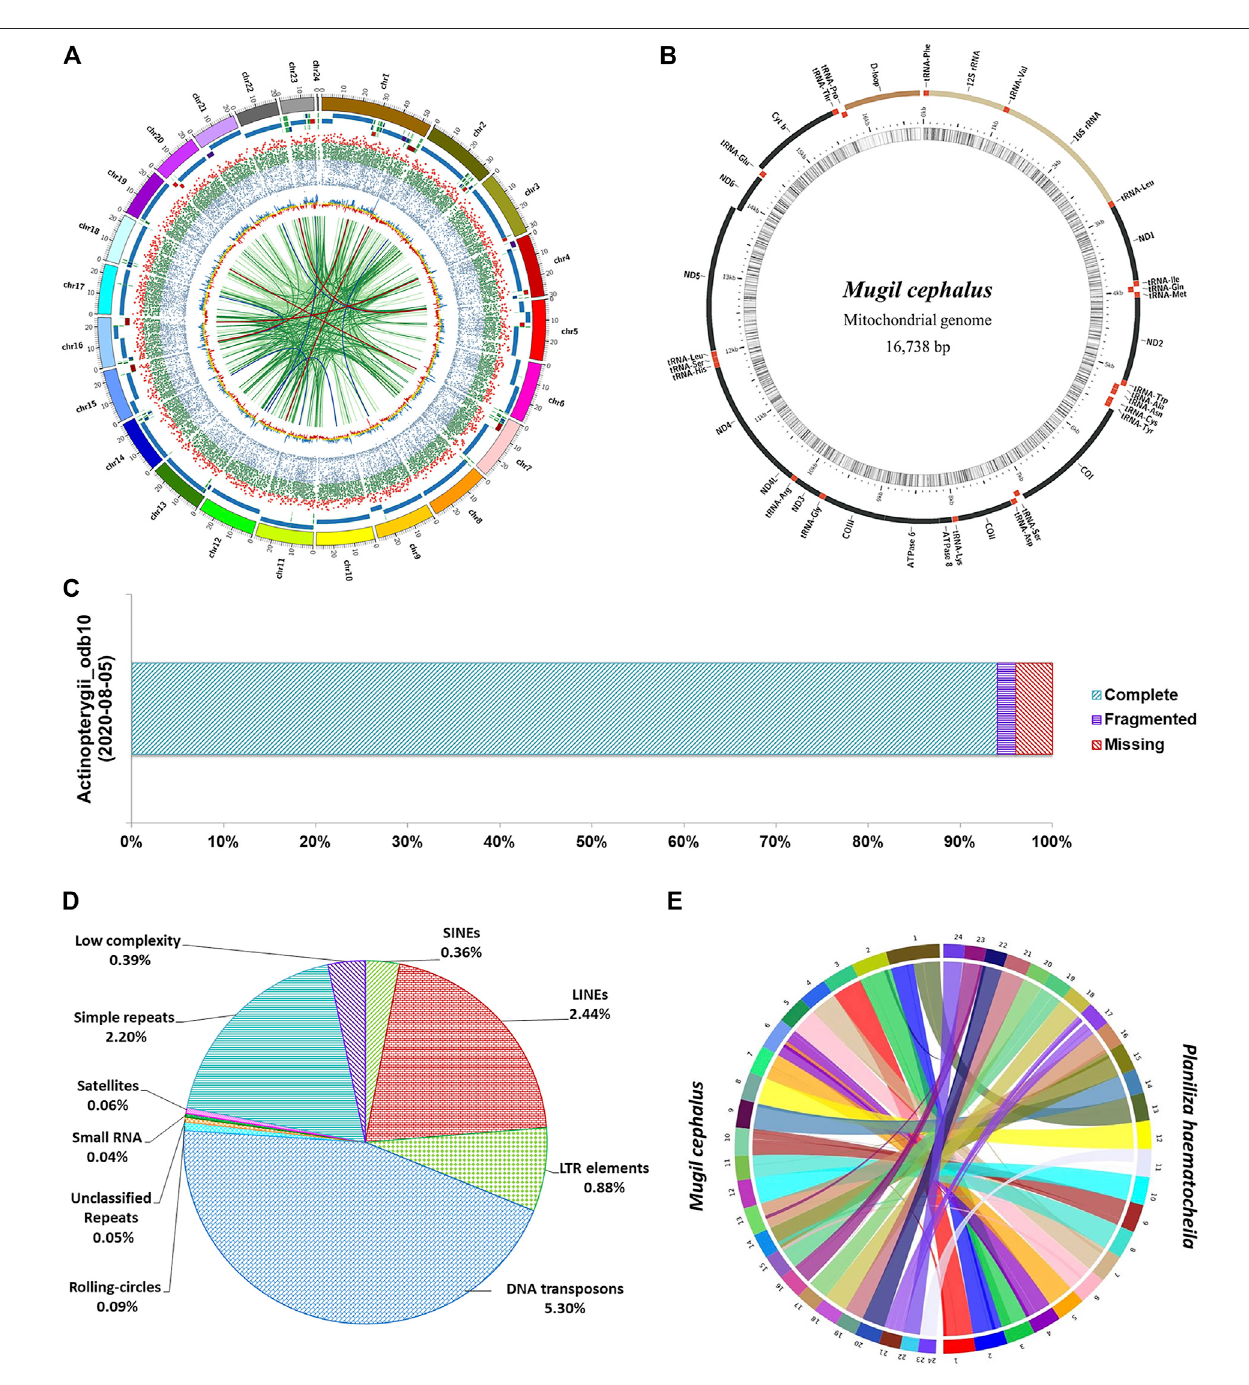
FIGURE 1 | Assembly of the M. cephalus genome. (A) Circos plot depicting the 24 pseudo-chromosomes in the M. cephalus assembly and their features. The track 1 (outermost) depicts 24 pseudo-chromosomes; track 2 depicts contigs represented as tiles (contigs < 5 Mb are shown in variable colors); track 3 shows protein- coding genes as a scatter plot (gene length of < 5 kb in blue, 5 – 30 kb in green > 30 kb in red); track 4 shows GC content of the genome as a yellow line plot (GC values > 43 in blue and < 41 in red); track 5 (innermost) depicts self synteny in the genome shown as a link plot (alignment lengths over 1,500 bp in light green, 2 – 3 kb in dark green, 3 – 3.5 kb in dark blue and > 3.5 kb in dark red). (B) Map of the complete mitochondrial DNA genome of M. cephalus . (C) BUSCO scores illustrating the completeness of the M. cephalus genome assembly. (D) Pro fi le of repetitive elements in the M. cephalus genome assembly. (E) Synteny plot between redlip mullet and grey mullet genome